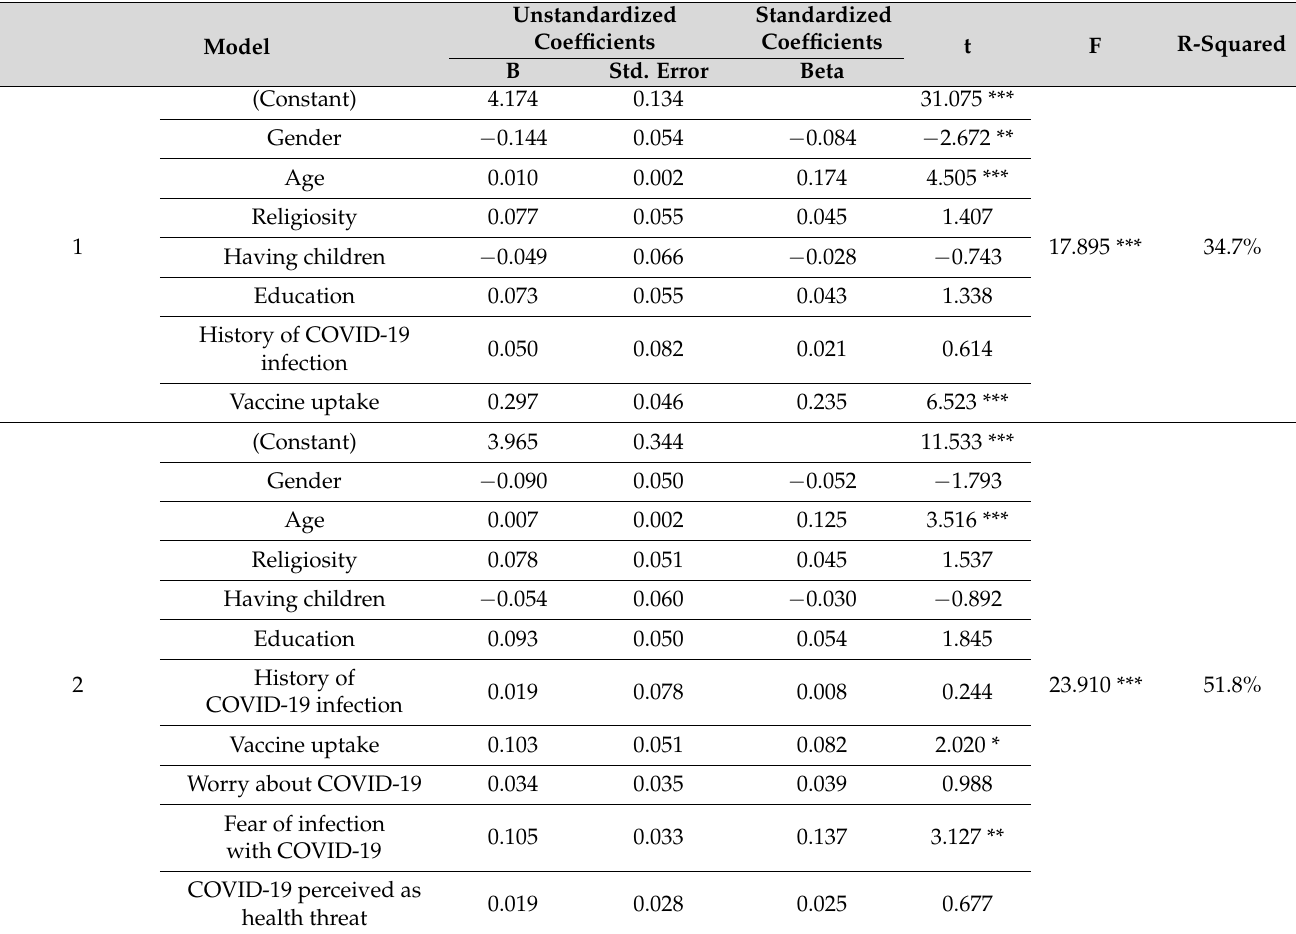
Table 4. Results of linear regression analysis to predict compliance with lockdowns ( N =